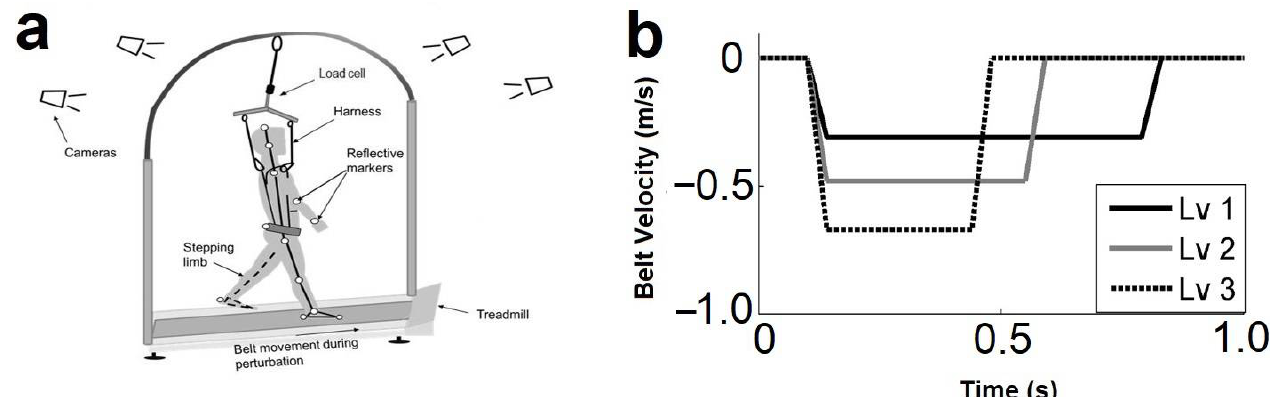
Figure 1. ( a ) Experimental set-up for slip-like perturbations. Reprinted with permission from Ref. [16]. 2016, Patel, P.J., ( b ) perturbation profiles of a treadmill slip. Each slip perturbation consists of three phases: acceleration, constant velocity, and deceleration. In the first phase (acceleration), the perturbation intensities were 7.75 m/s 2 (intensity 1), 12.00 m/s 2 (intensity 2), and 16.75 m/s 2 (intensity 3). In the second phase (constant velocity), the perturbation intensities were 0.31 (intensity 1), 0.48 (intensity 2), 0.67 m/s (intensity 3). All the three perturbation intensities led to the same slip distance of 0.2 m.